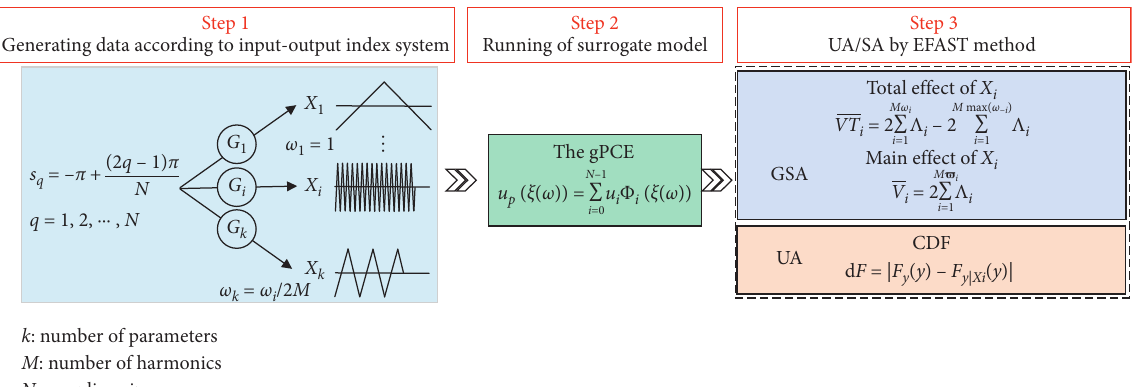
Figure 2: The UA/SA scheme that describes the required different steps for the computation of partial